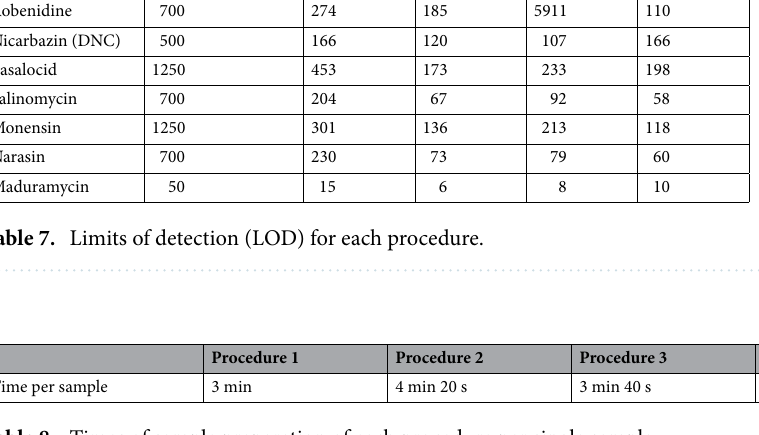
Table 8. Times of sample preparation of each procedure per single